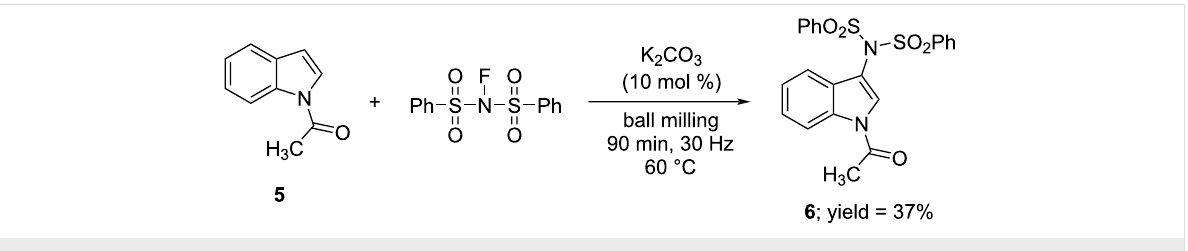
Scheme 4: Regioselective C-3 mechanochemical amidation of 5 with